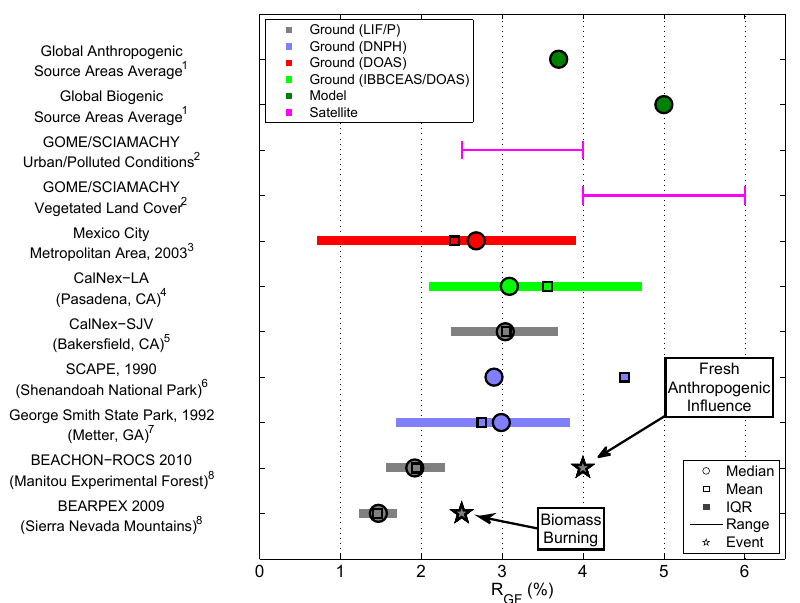
Fig. 7. R GF ranges during campaigns presented in this work and the literature. Circles denote the campaign medians, the squares denote the campaign means, and the lines denote the interquartile range (middle 50%) of the datasets. Stars denote biomass burning (MFI) and fresh anthropogenic (BN3) events during the campaigns discussed in this work. 1 Myriokefalitakis et al. (2008); 2 Vrekoussis et al. (2010); Folkard Wittrock, personal communication (2012); 3 Volkamer et al. (2005); 4 Gly: Washenfelder et al. (2011); HCHO: Warneke et al. (2011); 5 Henry et al. (2012); 6 Munger et al. (1995); 7 Lee et al. (1995), estimated from data in Fig. 8; 8 this